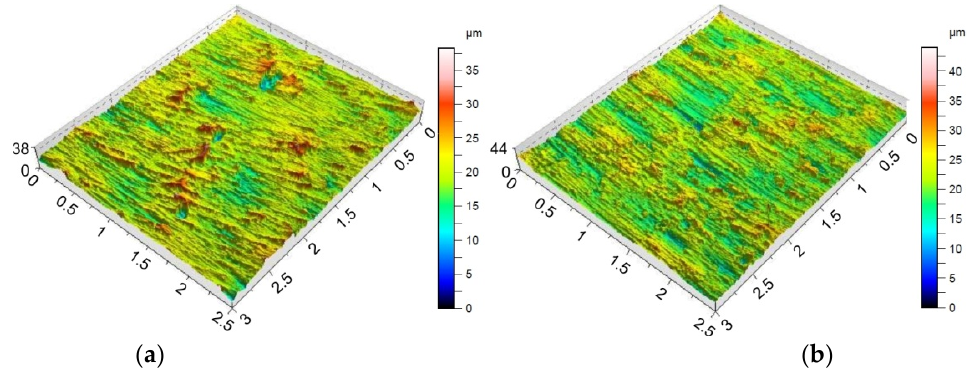
Figure 7. Topography of inside surface of the drawpieces formed at a p = 0.3 mm, f = 1250 mm/min, n = 400 rpm and toolpath strategy: ( a ) conventional and ( b ) climb.